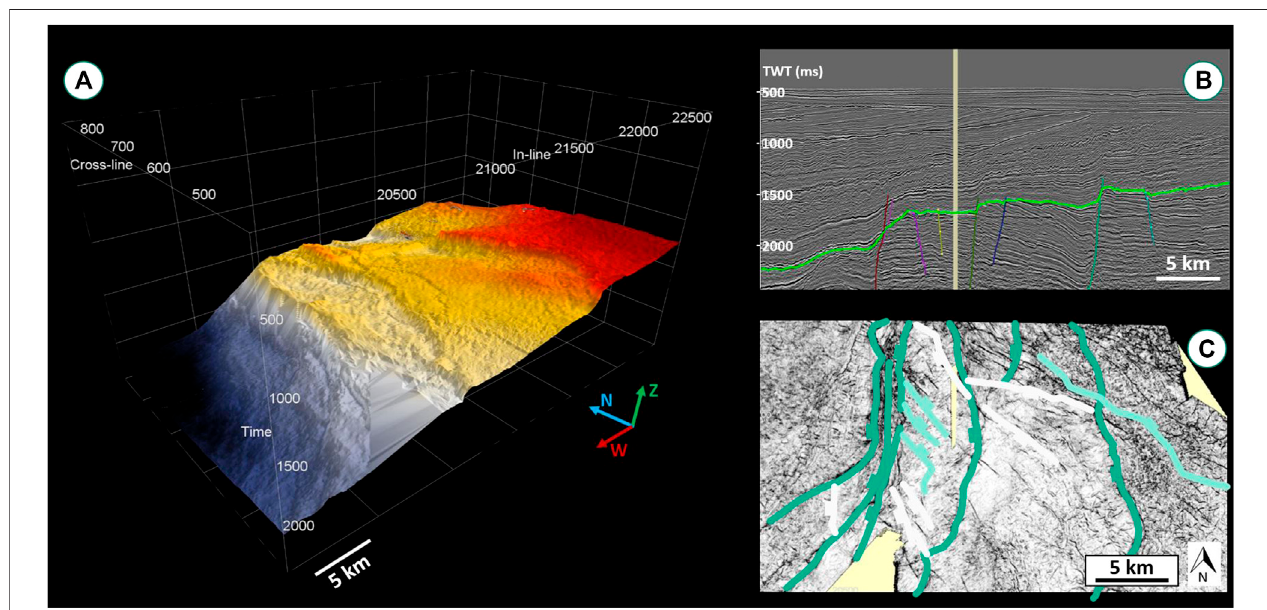
FIGURE1 | Seismic data areinterpreted byusing OpendTect software. (A) Reference surface ofthe geological structure model highlighted in the lightgreen line in Figure 1B . (B) Horizon and fault interpretation in cross section. (C) Fault interpretation on the reference surface.